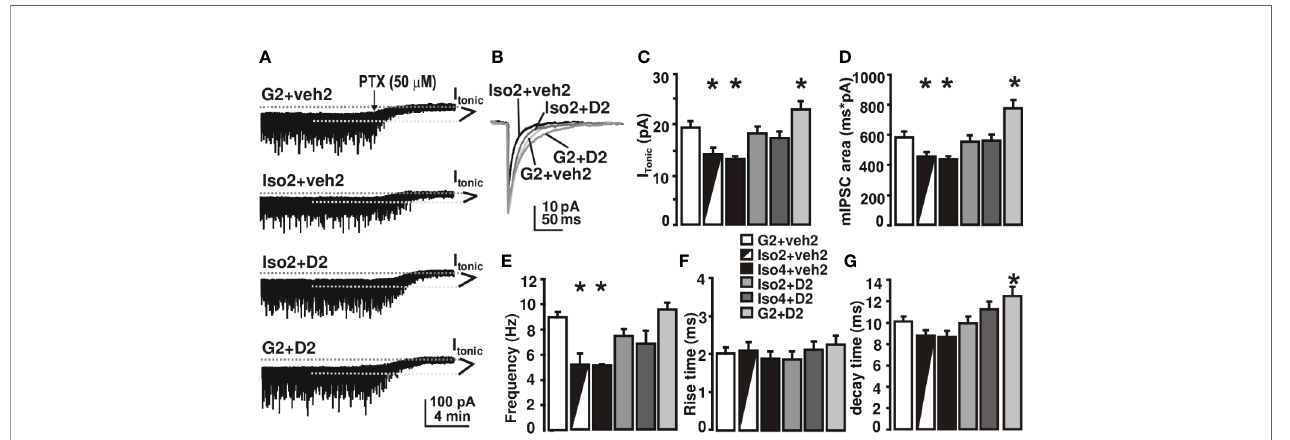
FIGURE 2 | DHM reverses social isolation-induced impairment in GABA A R-mediated neurotransmission. (A) Sample recording traces from different groups; (B) superimposed mIPSC peaks from different treatment groups. Picro: application of 50 m M of picrotoxin. GABA A R-mediated I tonic was calculated as the difference in holding current between the presence and absence of picrotoxin. (C) Summary of tonic currents from each group. (D – G) Summary of mIPSC kinetics. One-way ANOVA followed by multiple comparison, Sidak method. For tonic current, F(5, 64) = 8.62, p < 0.001. For mIPSC frequency, F(5, 63) = 9.0, P < 0.001. For rise time, F(5, 63) = 0.38, P = 0.86. For decay time, F(5, 64) = 5.76, P < 0.001. For mIPSC area, F(5, 63) = 9.62. P < 0.001. *, p ≤ 0.05 vs. group-housing control (G2 + Veh2); n = 4 mice/group; there could be multiple whole-cell patch recordings per mouse.